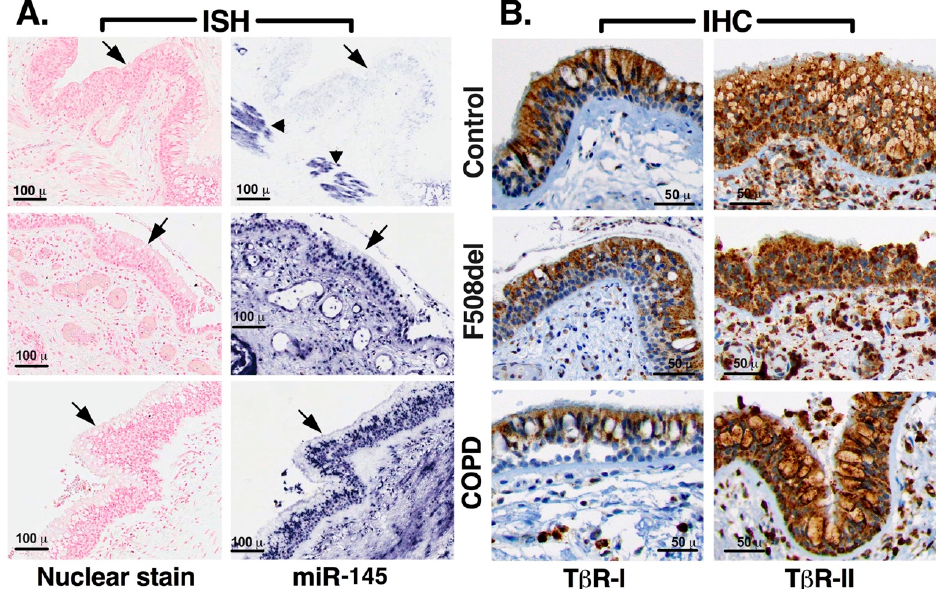
Figure 3. miRNA-145 expression was increased in native human bronchial epithelial samples from lung disease patients. ( A ). ISH images showing increased expression of miR-145 (arrows) in sections of bronchial epithelia from lungs homozygous for F508del ( n = 3) and COPD ( n = 2), compared to epithelia from lungs without chronic disease (control; n = 3). Previously reported high expression of miRNA-145 in the airway SMCs (arrowheads) was also noted. miR-145 was detected by locked nucleic acids (LNAs)™ miR-145 probe for ISH (Exiqon) and red nuclear stain was used as a counter stain. ( B ). IHC images showing similar expression of T β R-I and T β R-II in the CF and non-CF bronchial epithelia. T β R-I and T β R-II were detected with antibody AP08190PU-N and AP54233PU-N, respectively. Triplicate samples from each bronchial tissue per condition were used. Table 1. Expression scores of miR-145, T β R-I, and T β R-II from ISH and IHC experiments, as presented in Figure 3. Two blinded reviewers assigned a score between 0 and +3 based on the miR-145 expression level in bronchial epithelium. The agreement between reviewers was 100%. The expression of miR-145 varied in F508 epithelia but was increased, compared to controls. *, image shown in Figure 3. TISSUE MIR-145 T Β R-I T Β R-II